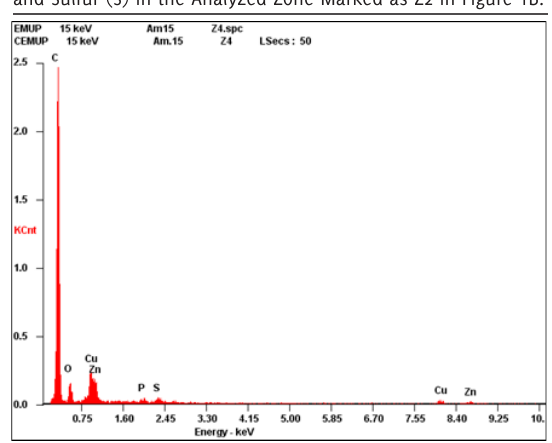
Figure 1C. X-Ray Microanalysis (XRM) Spectrum Showing the Ab- sence of Metals and the Presence of Normal Elements in Control Renal Tissue (Carbon (C), Nitrogen (N), Oxygen (O), Sodium (Na), and Sulfur (S) in the Analyzed Zone Marked as Z2 in Figure